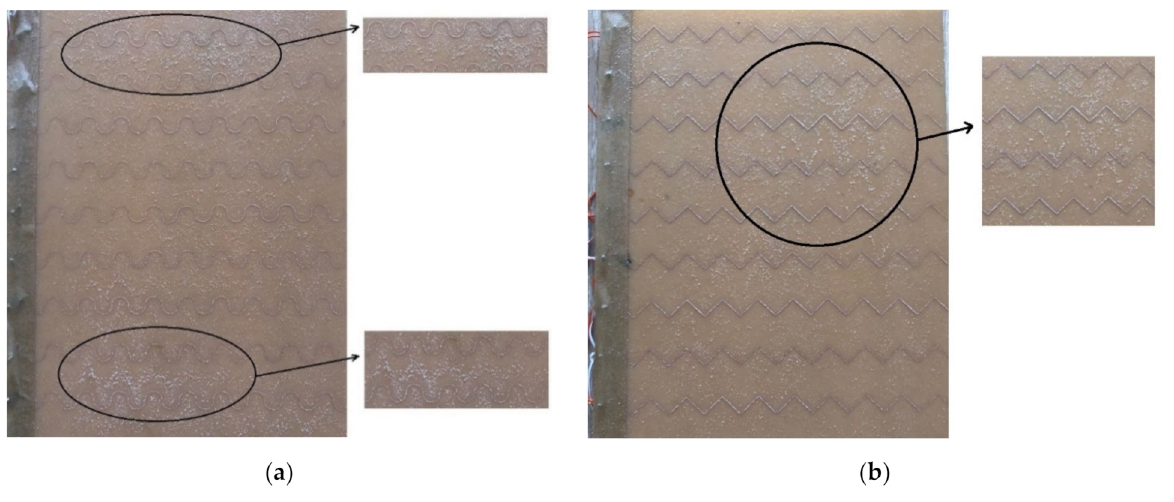
Figure 11. Dust distribution and accumulation as a result of single channel application to: ( a ) M3 model; ( b ) M4 model.